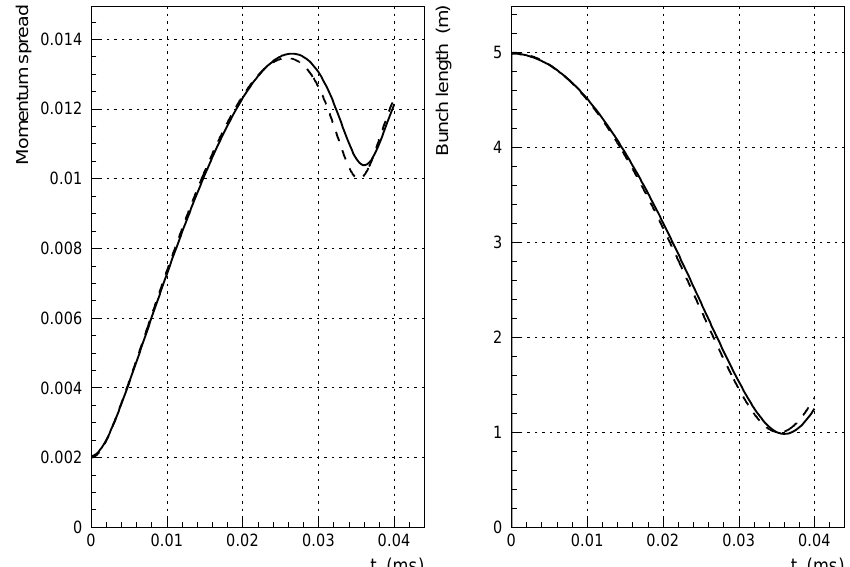
FIG. 6. Comparison of the envelope code result (dashed line) with a PATRIC particle-in-cell simulation for initial parabolic bunch with h (cid:1) 2 0.05 .